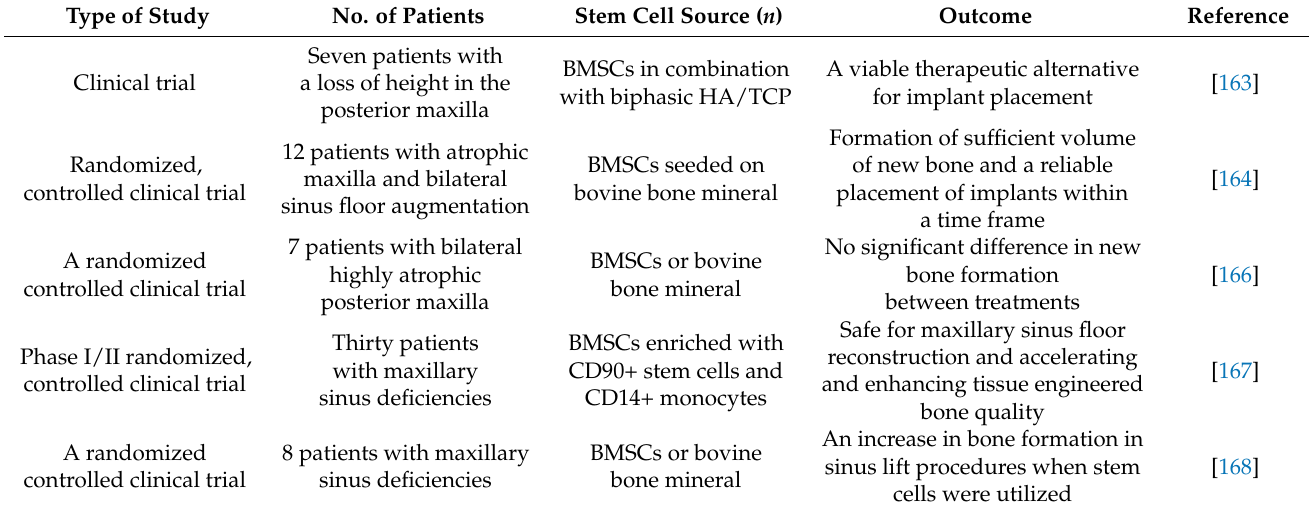
Table 6. Undertaken clinical trials in treatment of sinuses diseases using